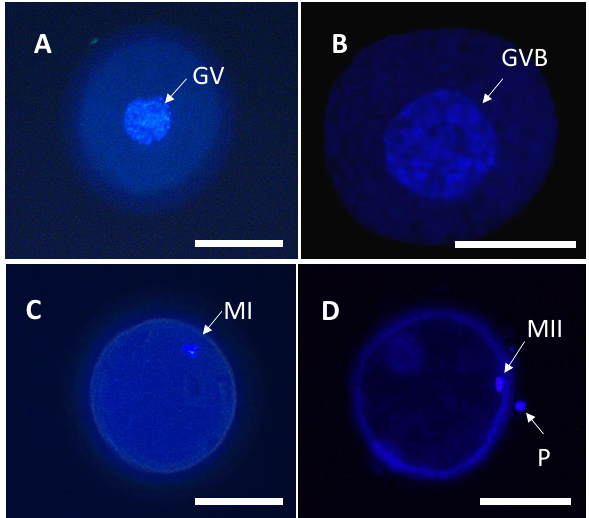
Figure 2. Meiotic stages in canine oocytes ( A ) Germinal vesicle (GV) immature or when the vesicle was clearly visible; ( B ) Germinal vesicle breakdown (GVBD) or resumption of meiosis; ( C ) First metaphase (MI) when chromosomes were condensed and present in equatorial view; ( D ) Second metaphase (MII) manifested by the presence of chromosomes in the second metaphase plate, with extrusion of the first polar body (PB). Samples were stained with 4 ′ -6-diamidino-2-phenylindole (DAPI) and observed under an epifluorescence inverted microscope. B ar = 100 μm , 200× magnifica- tion.